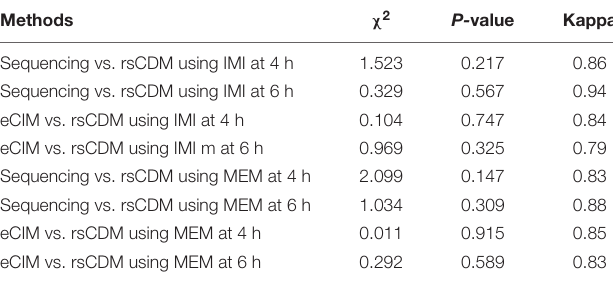
TABLE 3 | The statistic results of sequencing, rsCDM and eCIM for 225 Enterobacterales isolates.